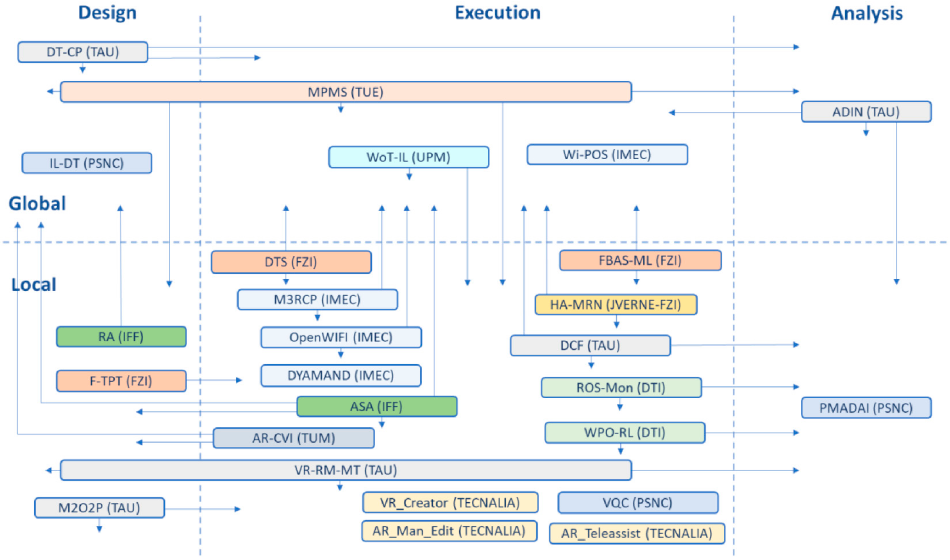
Figure 9. SHOP4CF software components in architecture landscape [37].